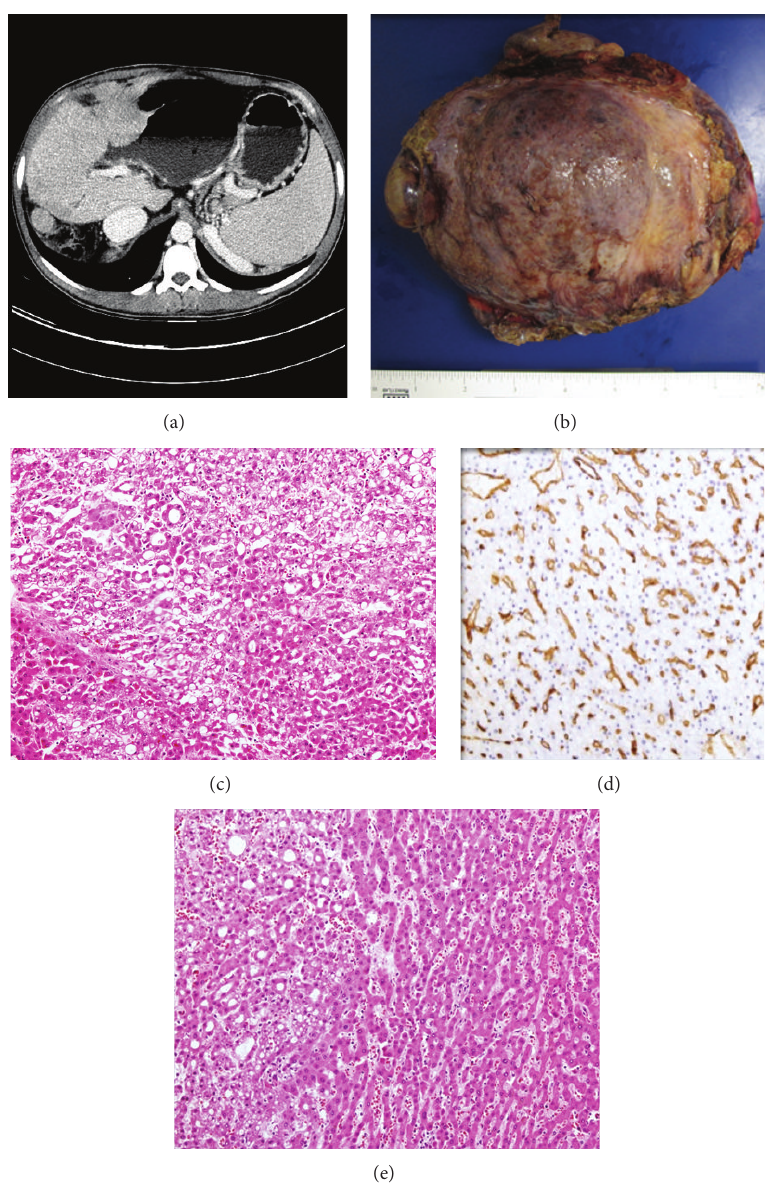
Figure 2: (a) CT scan of liver. (b) Gross picture showing nodular surface with somewhat exophytic mass on right. (c) Microscopic picture of mass, H&E, 20x. (d) Main mass with immunohistochemical stain for CD34 outlining neovascularization. (e) H&E of second “subnodule,”